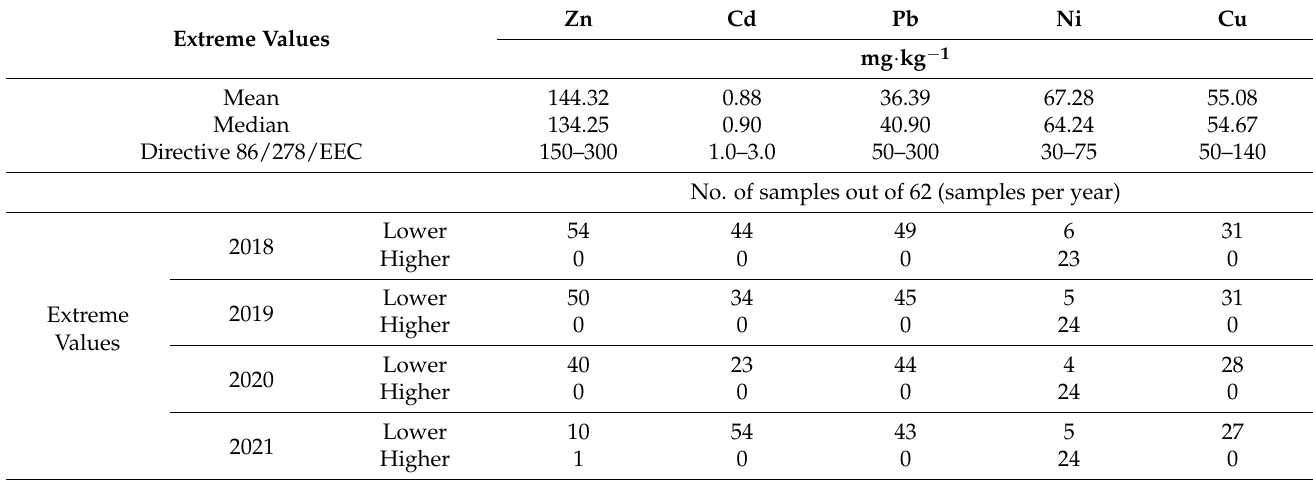
Table 3. Extreme values of the HMs according to Directive 86/278/EEC [58].